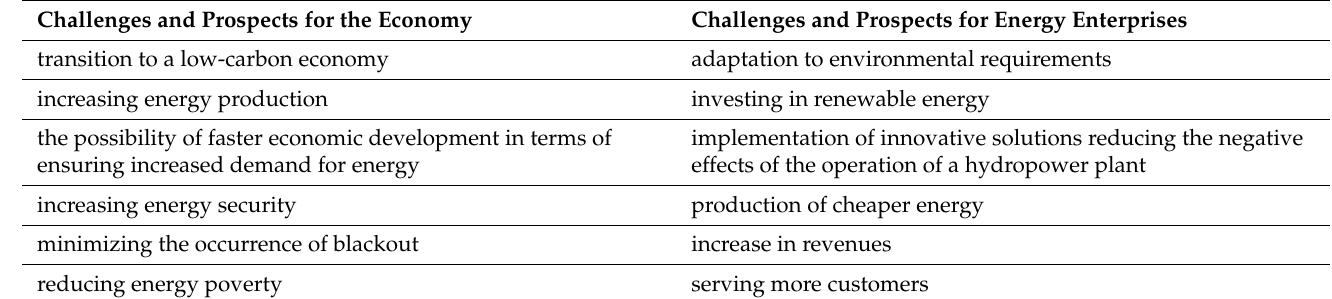
Table 6. Challenges and perspectives for the economy and energy